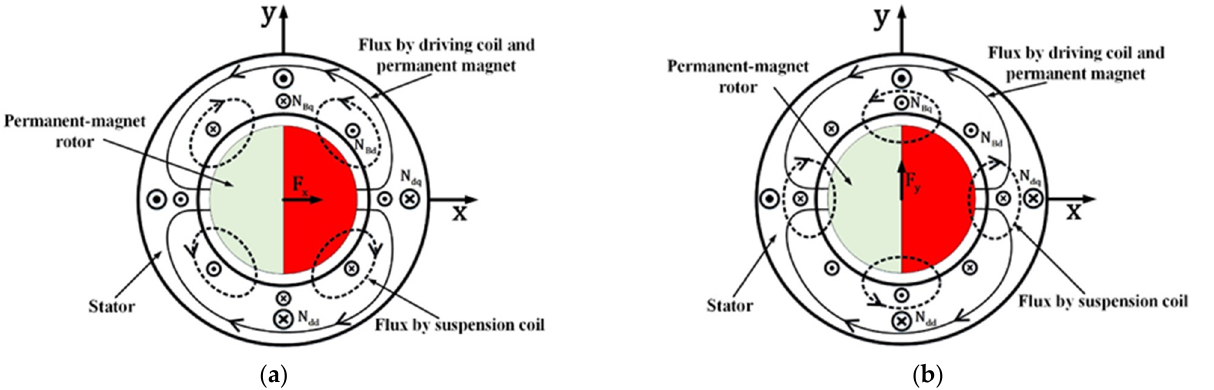
Figure 1. Principle of bearing force generation. ( a ) x -direction; ( b ) y -direction.